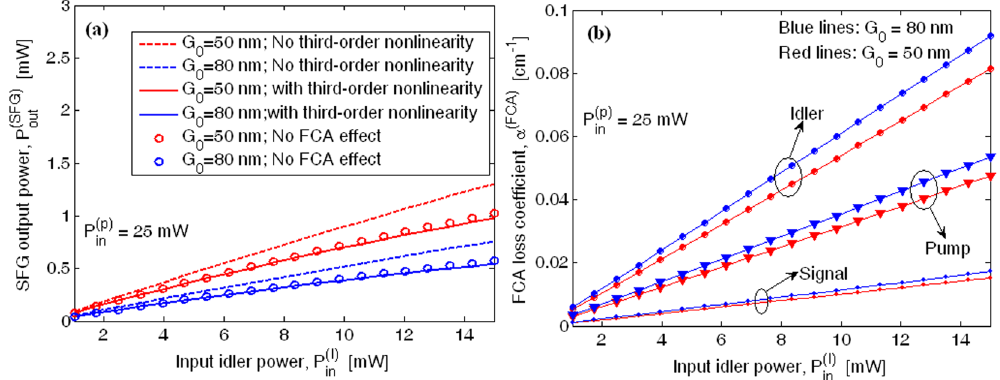
Figure 11. ( a ) Output SFG power versus input idler power for different values of the coupling gap; ( b ) FCA loss ciefficients versus input idler power for different values of the coupling